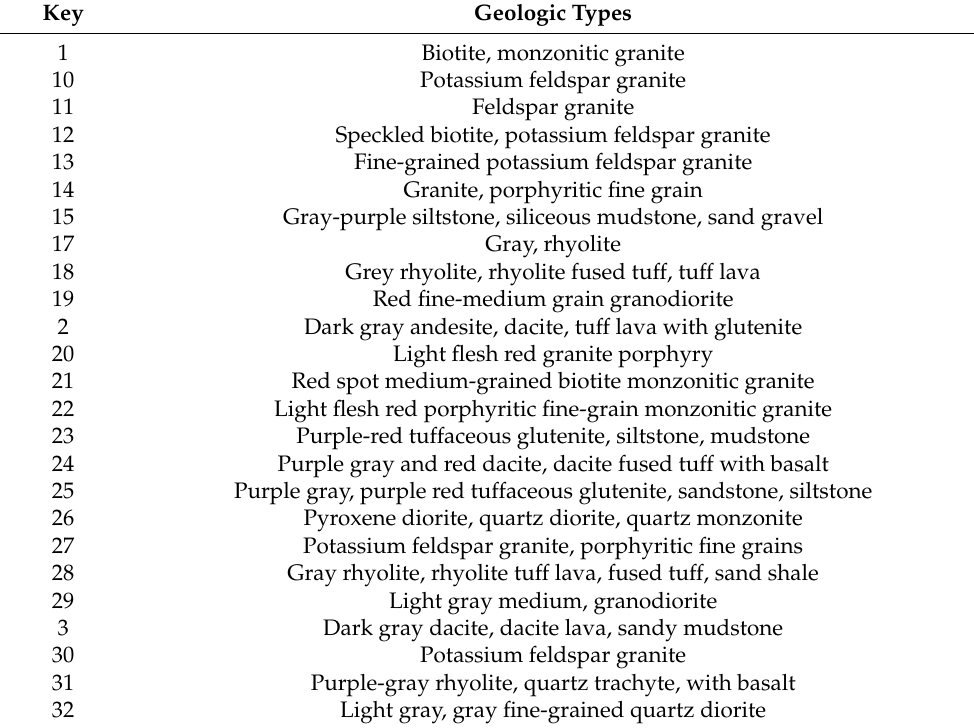
Table A1. Key to geological map (Figure